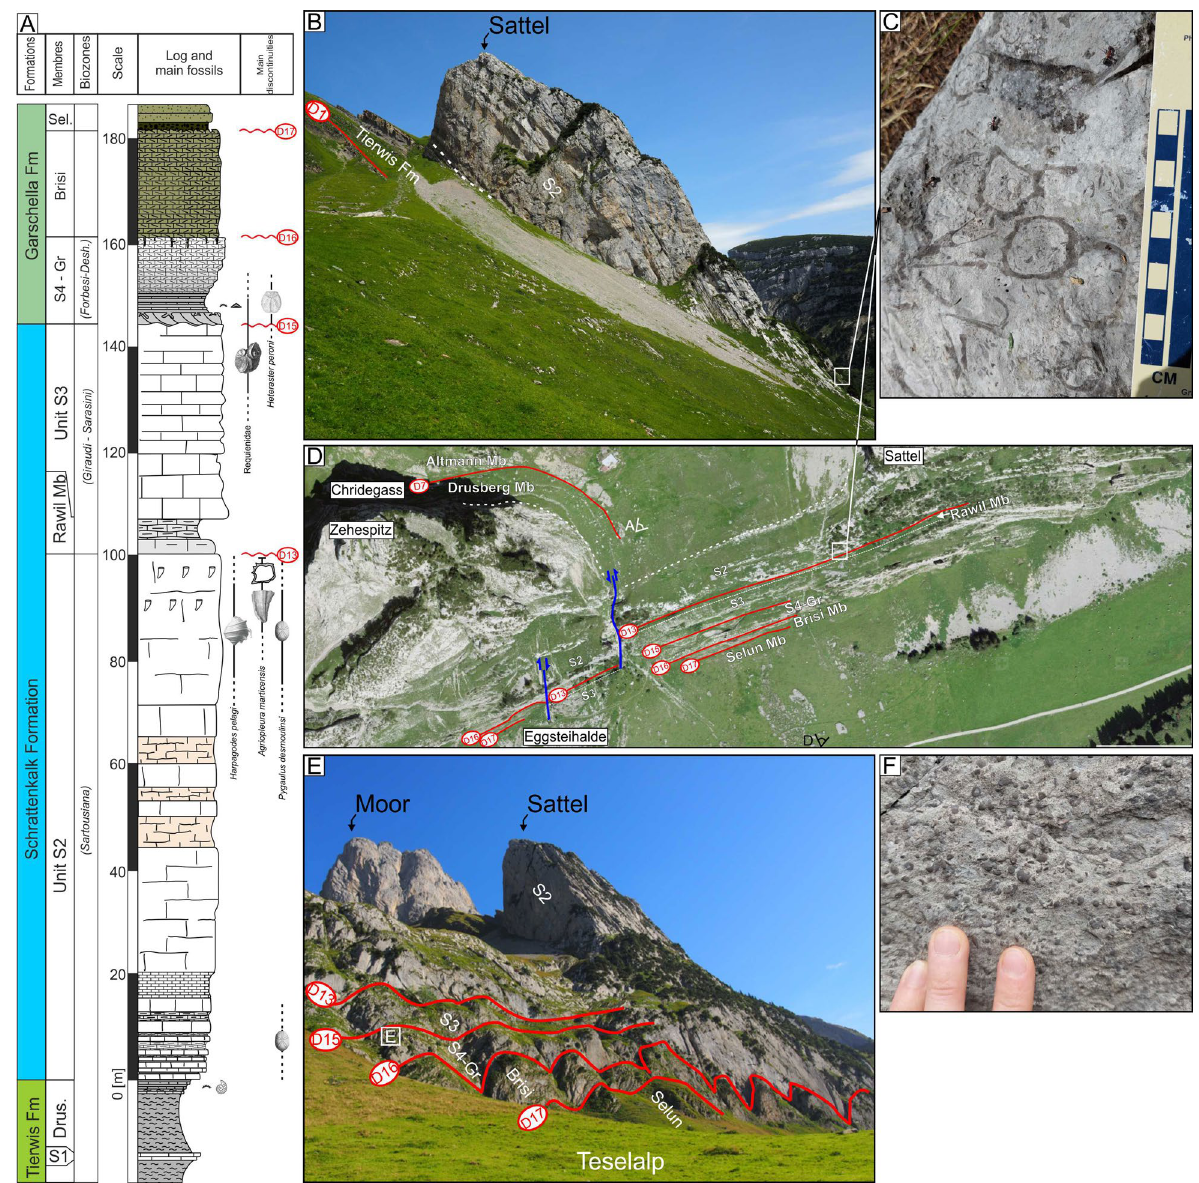
Fig. 12 A Lithological log of Litten-Chreialp ‑ Tesel section with discontinuity surfaces (D13 to D17). Rudist-shells drawings from Matheron (1842) and from Pictet and Campiches (1868–1871). Rudist-cross sections modified after Masse and Fernerci-Masse (2015). Harpagodes drawing from Pictet and Renevier (1854–1858). Echinoids drawings from Pictet and Renevier (1858) and Lambert (1920). B Litten-Chreialp—Tesel section. North-eastward view of Sattel from the pastures below Chridegass allowing the observation of the Tierwis Formation and lower part of the Schrattenkalk Formation (unit S2). C Focus on the Agriopleura -bearing beds on top of unit S2. D Orthophoto (© swisstopo) between Zehespitz and Sattel with the path rising from Eggsteihalde to Wildhuser Schofbode on which are reported the main lithostratigraphic units and discontinuity surfaces are displayed. E North eastward view of Sattel from the lower pastures of Tesel showing the lithostratigraphic succession and the discontinuity surfaces between the unit S2 of the Schrattenkalk formation and the Selun Member of the Garschella Formation above. F Focus on the Palorbitolina lenticularis-bearing marlstone in the lower third of the Grünten Member cropping out along the